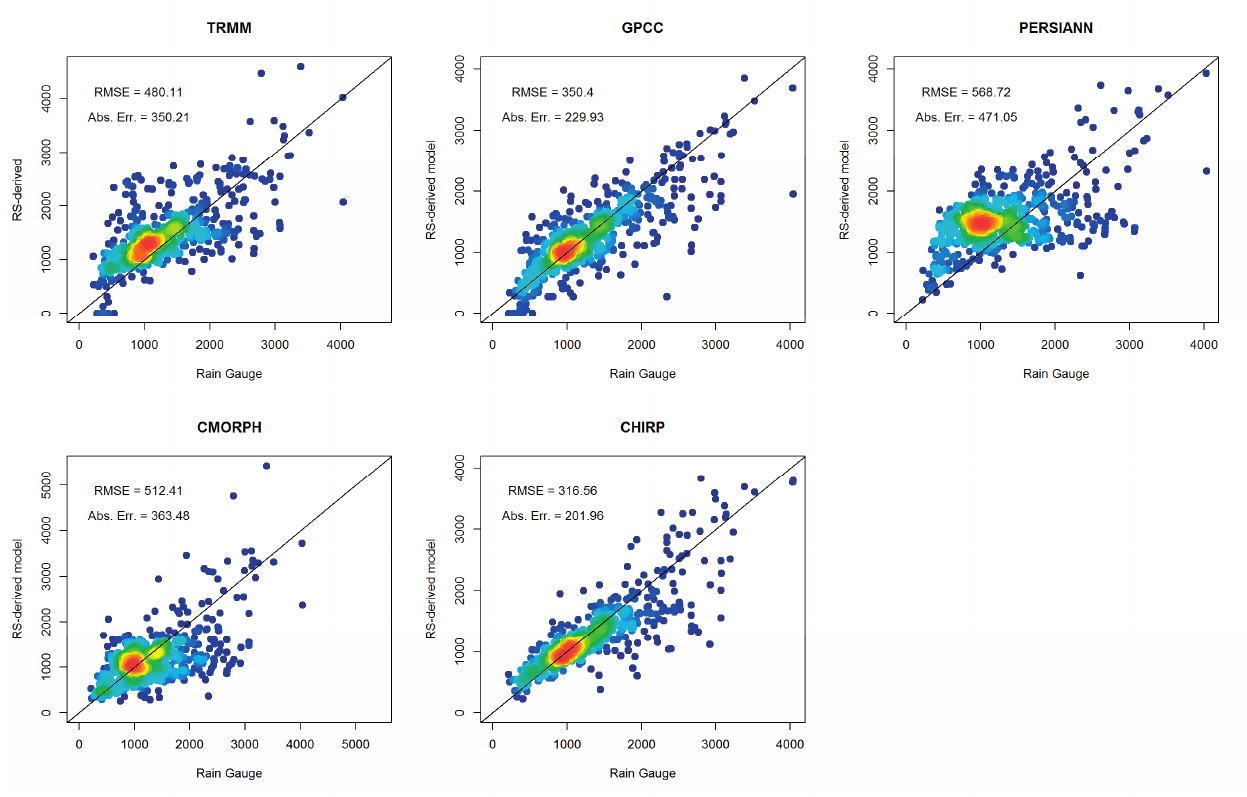
Figure 11. Scatterplot of Rain gauges vs. Satellite-derived precipitation for Venezuela.